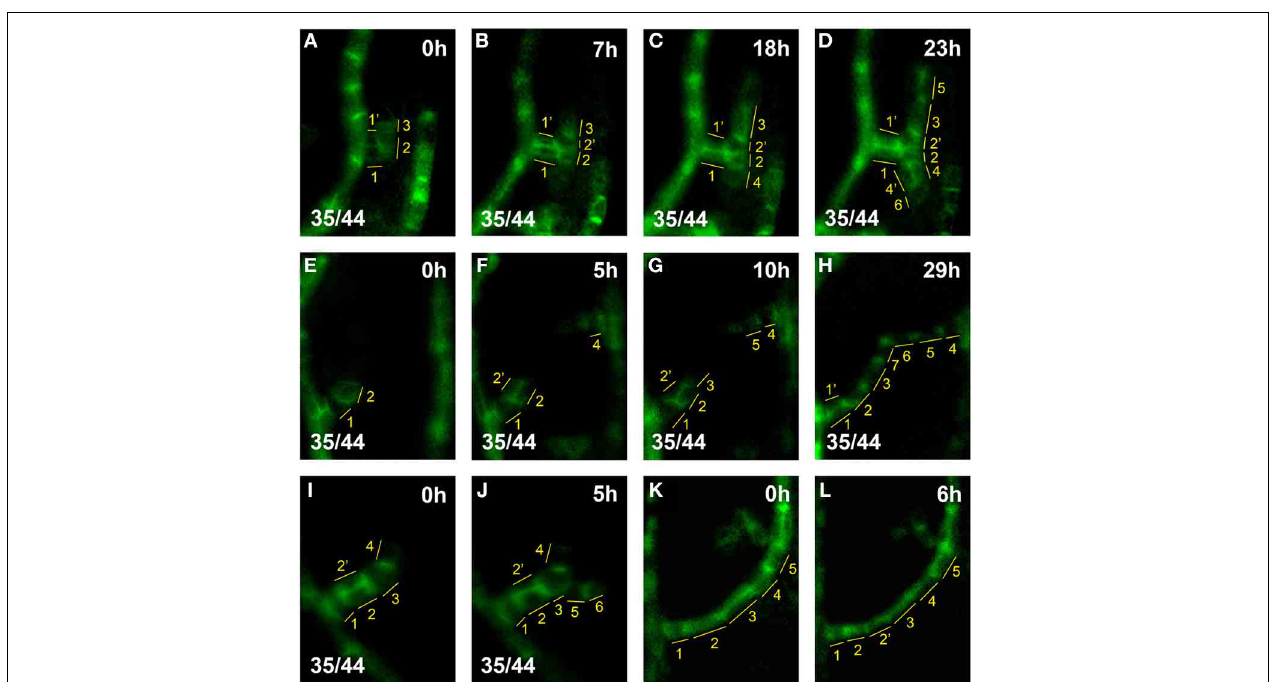
FIGURE 3 | hPED extension by terminal addition vs. intercalation. Top right, time after first imaging time point. Bottom left, reproducibility quotient ( Table 2 ). Scale bars: (A–L) 10 µ m. (A–D) hPED extension via terminal addition: At 0h, a freely-ending hPED of four cells branching from the first loop ( A , cells numbered in yellow). By 18h, Cell 4, next to Cell 2, upregulated PIN1 . By 23h, Cells 5 and 6 were also added to the hPED, next to Cells 3 and 4, respectively. During the live imaging period, Cells 2 (cid:3) and 4 (cid:3) were also added, via the divisions of Cell 2 (at 7h) and Cell 4 (at 23h), respectively. However, these cell divisions did not increase the length, but rather the width, of the PED. (E–H) PED extension and fusion via terminal addition: At 0h, a freely-ending hPED branching from the first loop ( E , cells numbered in yellow). By 5h, Cell 4, has upregulated PIN1 generating a new freely-ending